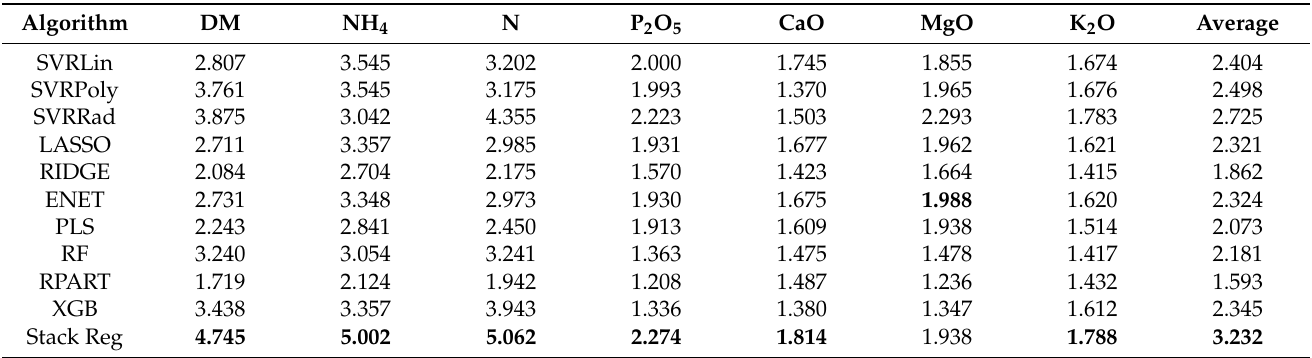
Table 8. Comparison of the ratio of performance to deviation ( RPD ) in the testing set among the seven chemical components: dry matter (DM), total ammonium nitrogen (NH 4 ), total nitrogen (N), P 2 O 5 , CaO, MgO and K 2 O of the fresh homogenized samples using various machine learning tech- niques (SVRLin = support vector regression with linear kernel; SVRPoly = support vector regression with polynomial kernel; SVRRad = support vector regression with radial kernel; LASSO = least absolute shrinkage and selection operator; RIDGE = ridge regression; ENET = elastic net regression; PLS = partial least squares; RF = random forests; RPART = recursive partitioning and regression trees; XGB = boosted trees). Best results are indicated in